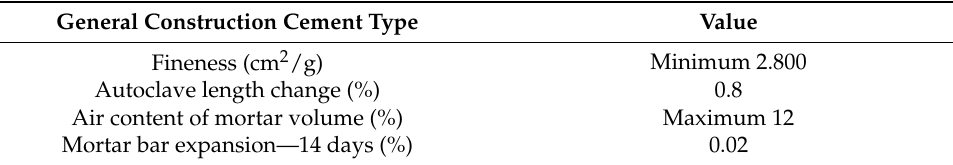
Table 1. Standard physical requirements of cement of general use